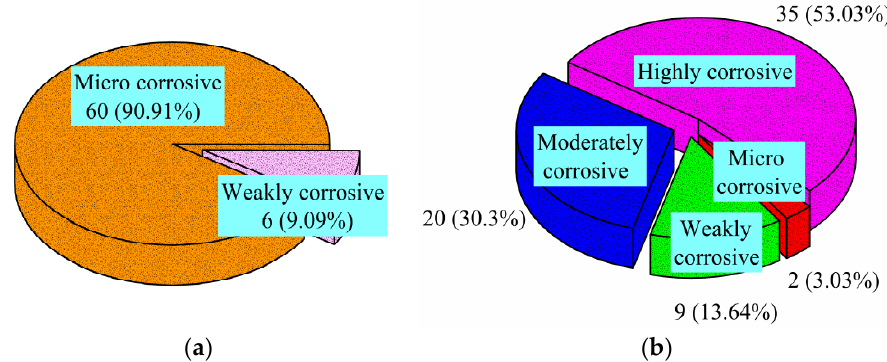
Figure 2. Distribution of the chloride ion content in the groundwater of subway tunnels from Qingdao: ( a ) long-term immersion; ( b ) dry–wet alternation.